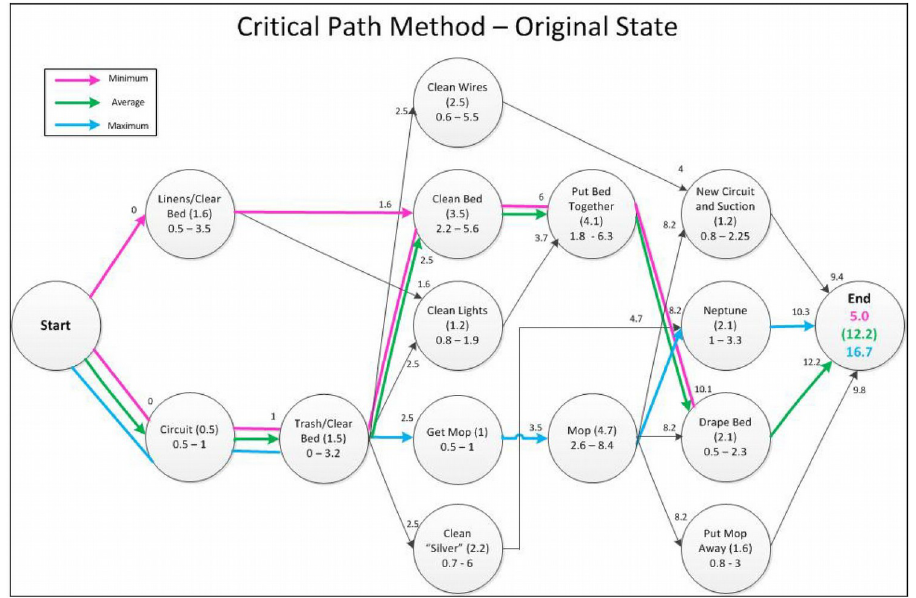
Figure 4. CPM for the original cleaning